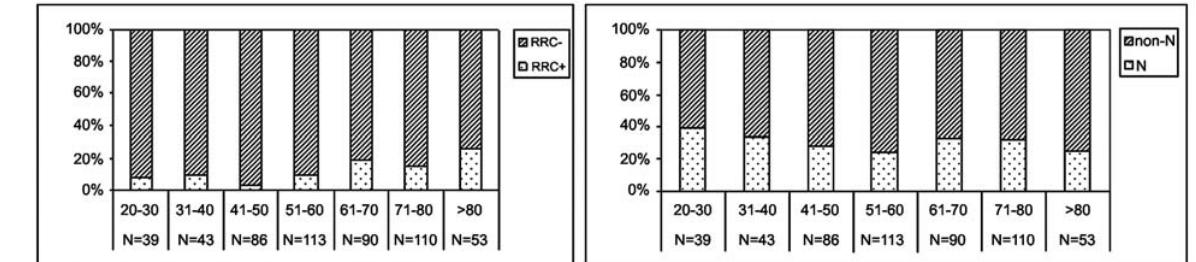
Figure 1 – Analysis of the entire population (534 female patients). Left: incidence of rhythmic rectal contractions with age. Right: incidence of neurological disease with age.